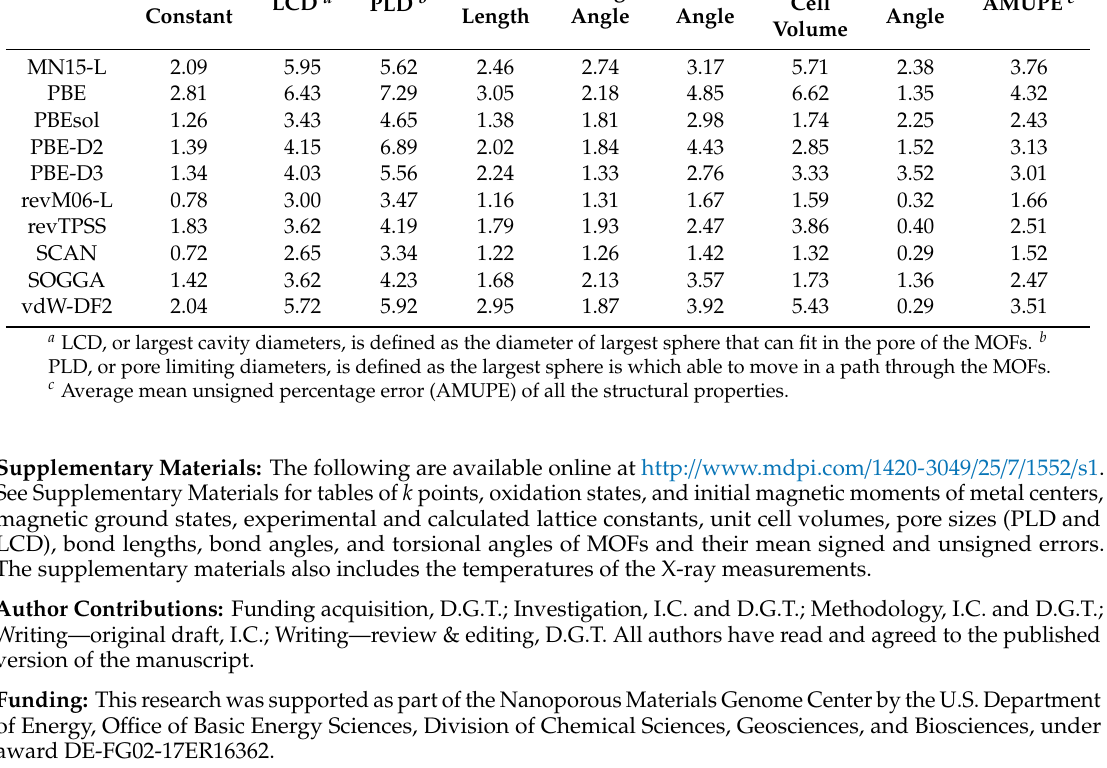
Table 2. Mean unsigned percentage errors (MUPE) and average mean unsigned percentage error (AMUPE) of structural parameters of MOFs. Lattice LCD